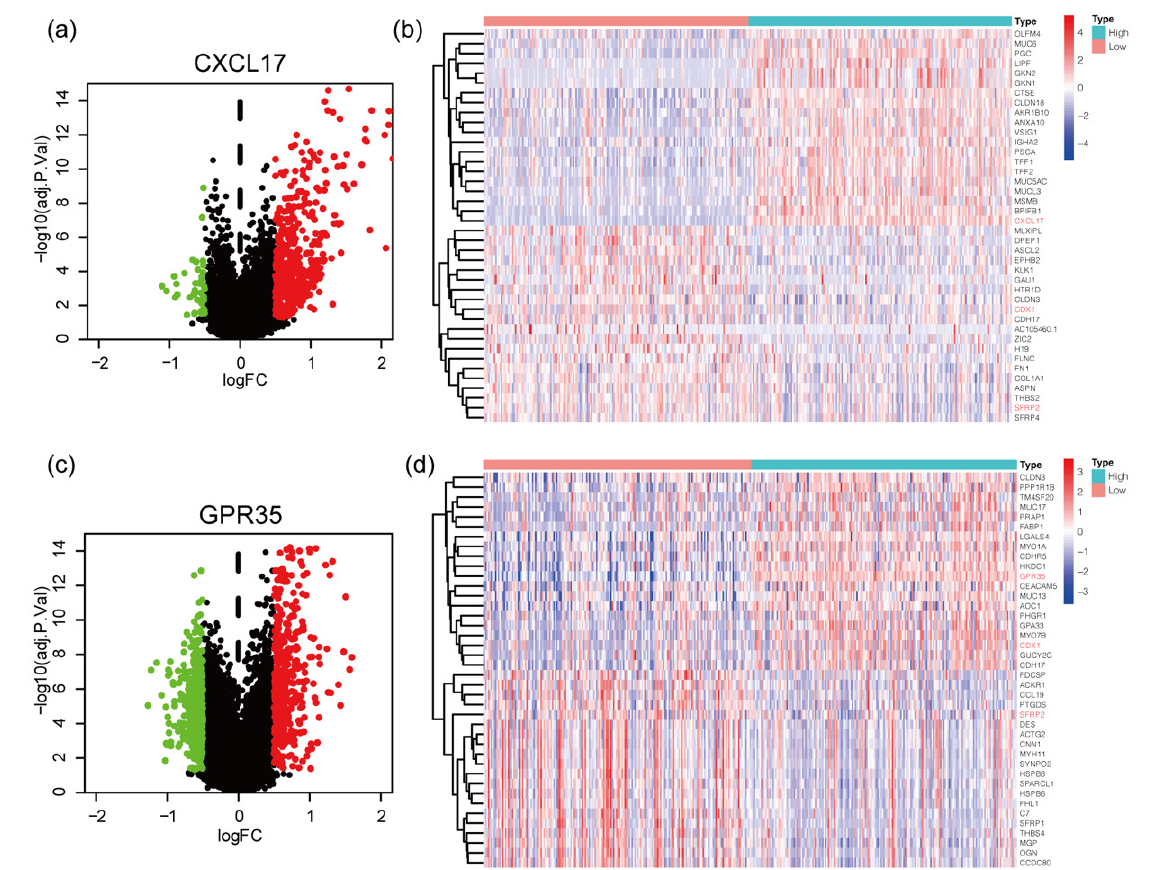
Figure 5. Identification of DEGs of CXCL17 ( a ) and GPR35 ( c ); the red color is indicative of upregu- lated genes and the green color is indicative of downregulated genes. The heatmaps displayed the top 20 down- and upregulated genes of CXCL17 ( b ) and GPR35 ( d ). The top DEGs shared by CXCL17 and GPR35 are in red. DEGs, differentially expressed genes.